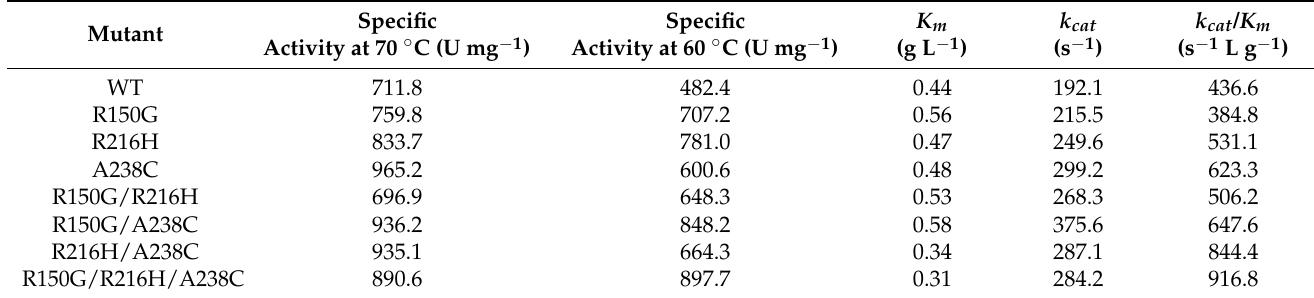
Table 4. Activity and kinetic parameters of the wild-type BacPelA and